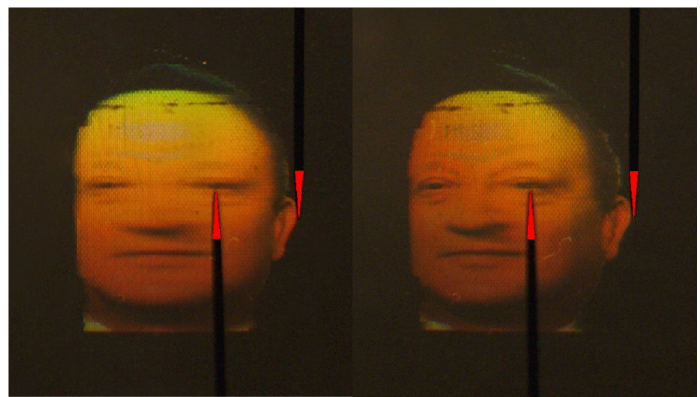
Figure 11. Measurement of the parallax of the hologram-reconstructed image by porting it out into the measurement space; the tips of the needles are highlighted in red.